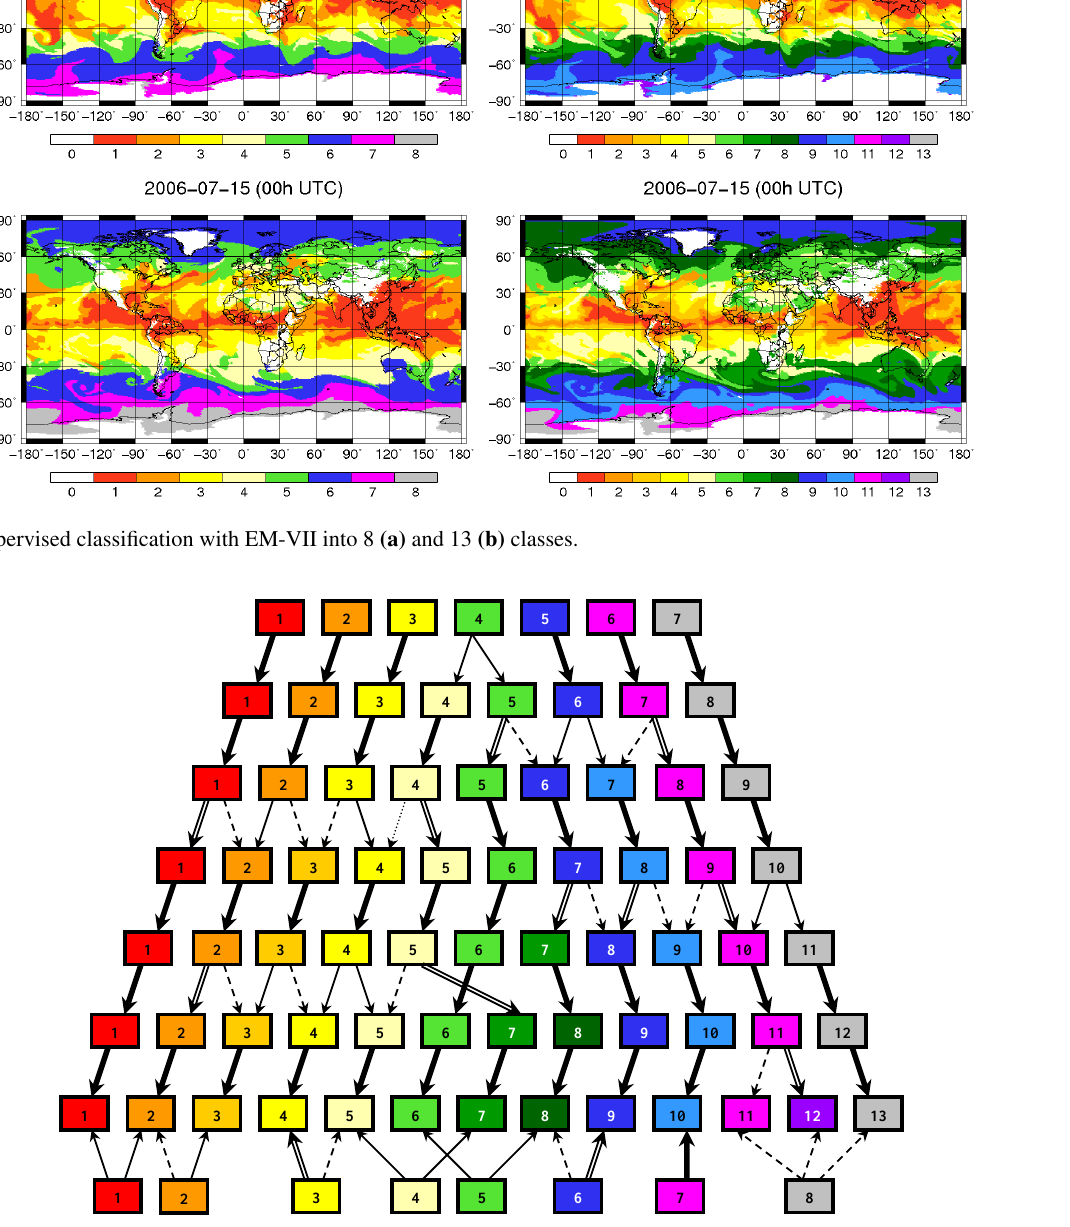
Figure 10. Arrow diagram illustrating the correspondence between the K classes of the unsupervised classification results obtained with EM-VII from K = 7 to K = 13. The classes are indicated by their number (from 1 to K ). The evolution from one classification to the next one is indicated by the arrows. The style of the arrows characterizes the percentage of atmospheric situations shared relative to the size of the original class: bold (higher than 80%), doubled (between 80 and 60%), single (between 60 and 40%), dashed (between 40 and 20%), dotted (lower than